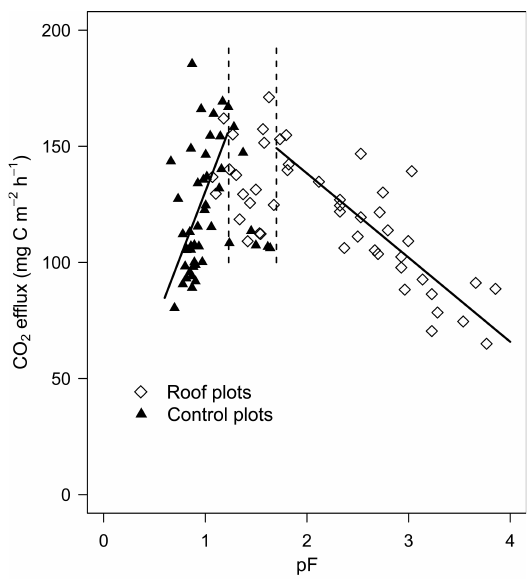
Fig. 4. Relationship between soil water potential (pF) at 10cm depth and soil CO 2 efflux. The regression equation at the wet end of the moisture spectrum is CO 2 efflux = 114.35(pF)+16.13 ( R 2 = 0 . 34, P > 0 . 01) and at the dry end CO 2 efflux =− 36.26(pF)+210.86 ( R 2 = 0 . 71, P > 0 . 01).